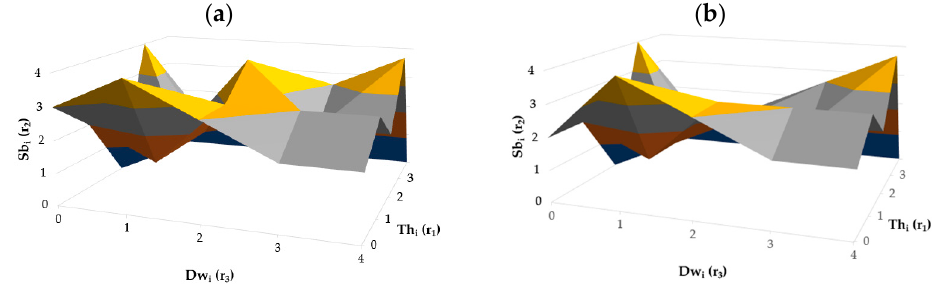
Figure 6. Comparison between predicted values ( a ) of output parameters ( r 1 , r 2 , r 3 ) and actual values ( b ) of same parameters, evaluated in case of spreading r 6 = 0 (not-dewatered sludge on agricultural land) and r 4 = r 5 = 0.